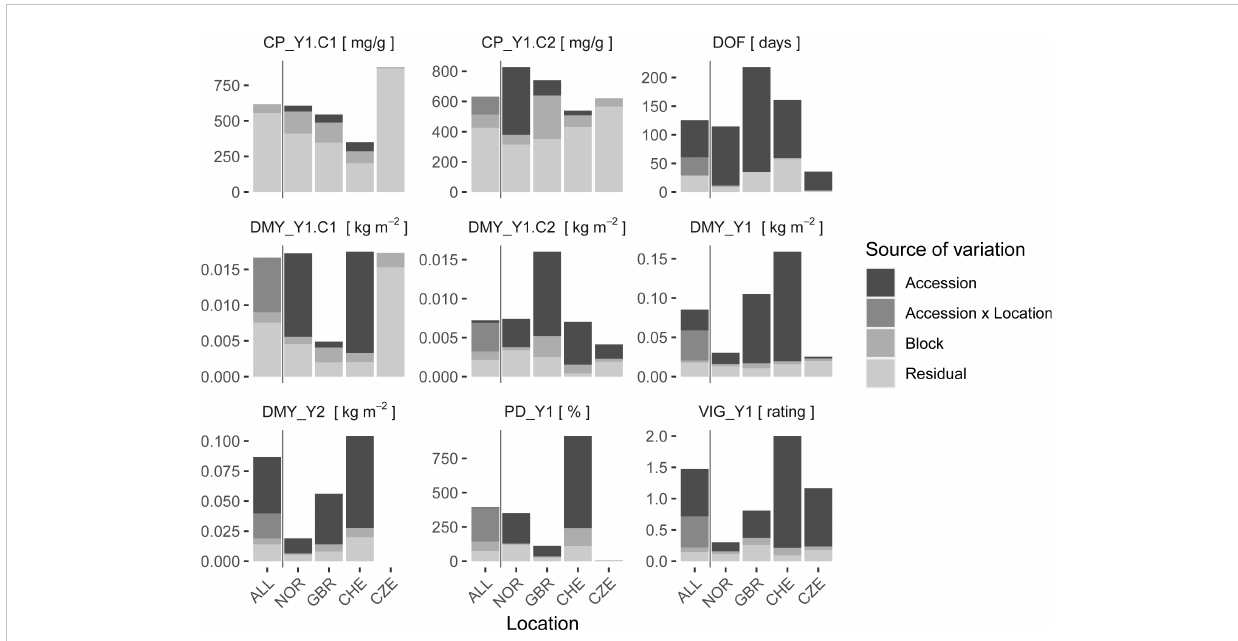
FIGURE 5 Variance components of single locations (NOR, GBR, CHE, CZE) and multi-location models (ALL). The variation attributed to the red clover accession, fi eld heterogeneity as assessed by incomplete blocks (Block), the interaction of accession x location (for multi-location model only) and residuals is shown. Traits are crude protein content (CP), date of fl owering (DOF), dry matter yield (DMY), plant density in autumn (PD) and plant vigor (VIG). Extensions _Y1 and _Y2 denote the fi rst and second main year of observation, .C1 and .C2 the fi rst and second cut per year, respectively. If the cut number is not speci fi ed, average values for VIG and sum of values for DMY over one year were